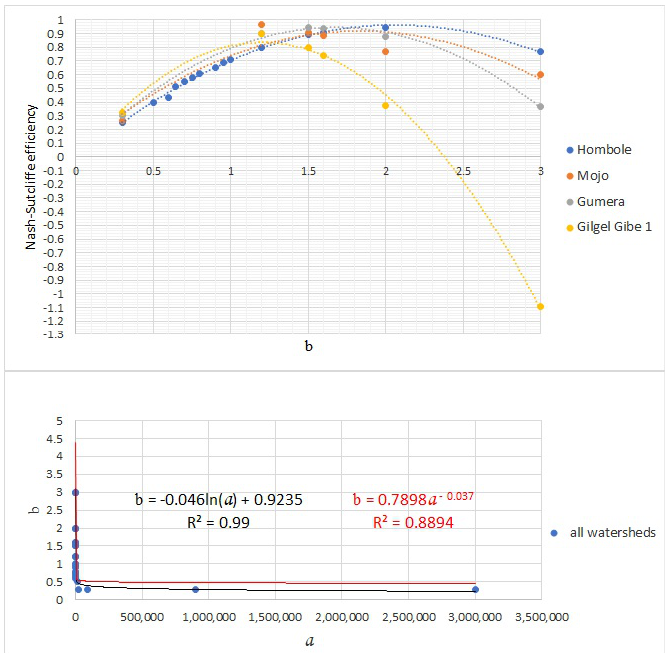
Figure 11. The relationship between exponent b versus the Nash–Sutcliffe efficiency and coefficient a versus exponent b when the topographic factor is calculated by using the equation that was proposed by McCool et al. (1987), as cited in [25].